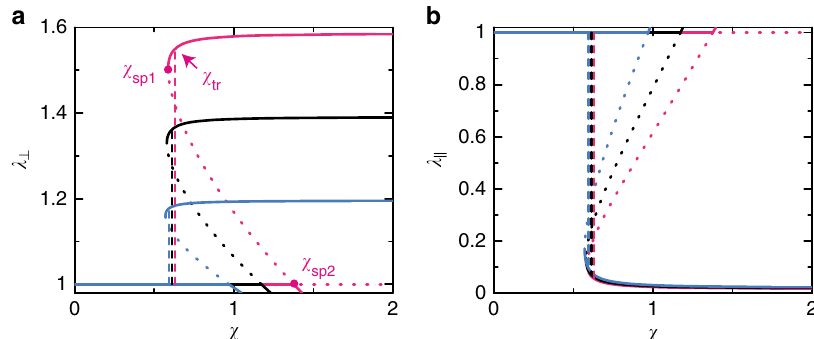
Fig. 3 The extension ratios vs the interaction parameter χ . The extension ratios, λ ⊥ ( a ) and λ || ( b ), of a unit cell are shown as functions of the interaction parameter χ (see Fig. 1 for the de fi nition of λ ⊥ and λ || ). We used ( r ex − r in )/ r in = 0.1 (cyan), 0.2 (black), and 0.3 (magenta) for the calculations (see Fig. 1 for the de fi nition of the radii r ex and r in ). The stable solutions are shown by solid curves and the unstable solutions are shown by dotted curves. The global minimum of the free energy changes between the two stable solutions at a threshold interaction parameter χ tr , indicated by broken curves. The value of the rescaled shear modulus g 0 (de fi ned by Eq. (9)) is fi xed to 1.0 × 10 −